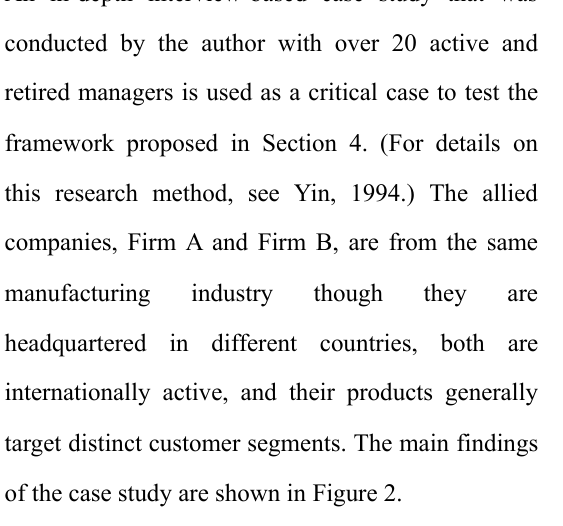
Figure 1: Inter-firm teaching and learning